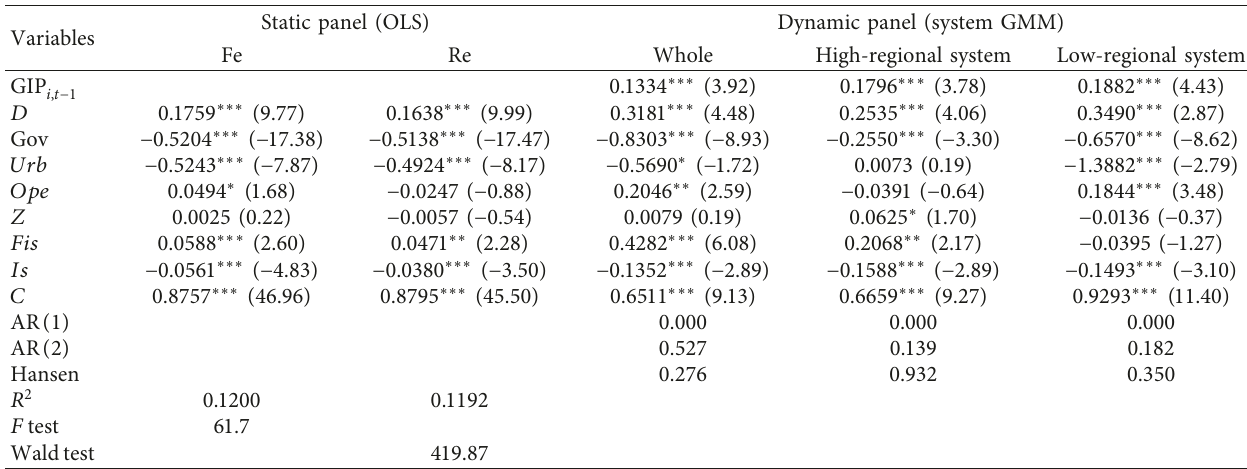
Table 3: Benchmark regression results.